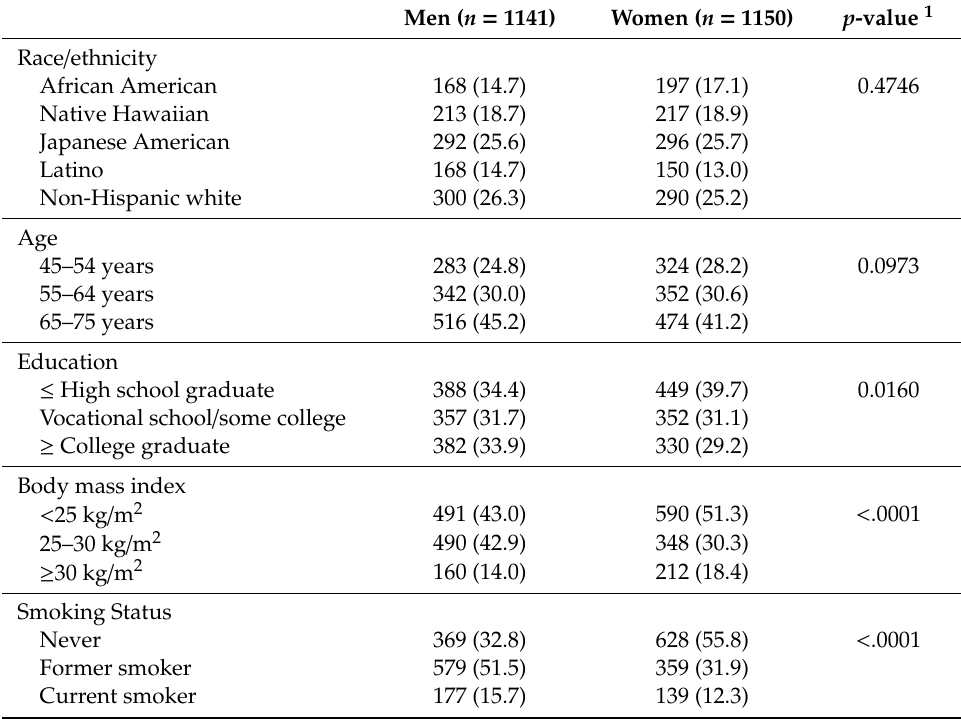
Table 1. Baseline characteristics of participants who completed the quantitative food frequency questionnaire and three 24 h dietary recalls in the calibration study of the Multiethnic Cohort. Men ( n = 1141) Women ( n = 1150) p -value